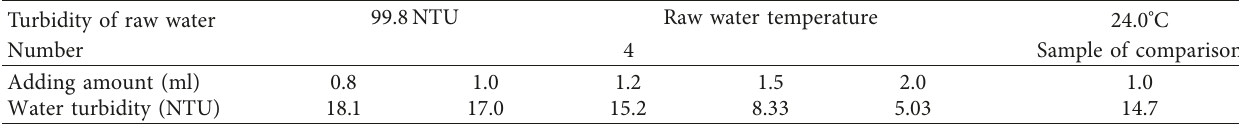
Table 6: Formula no. 4 treatment of tap water source water-related case.